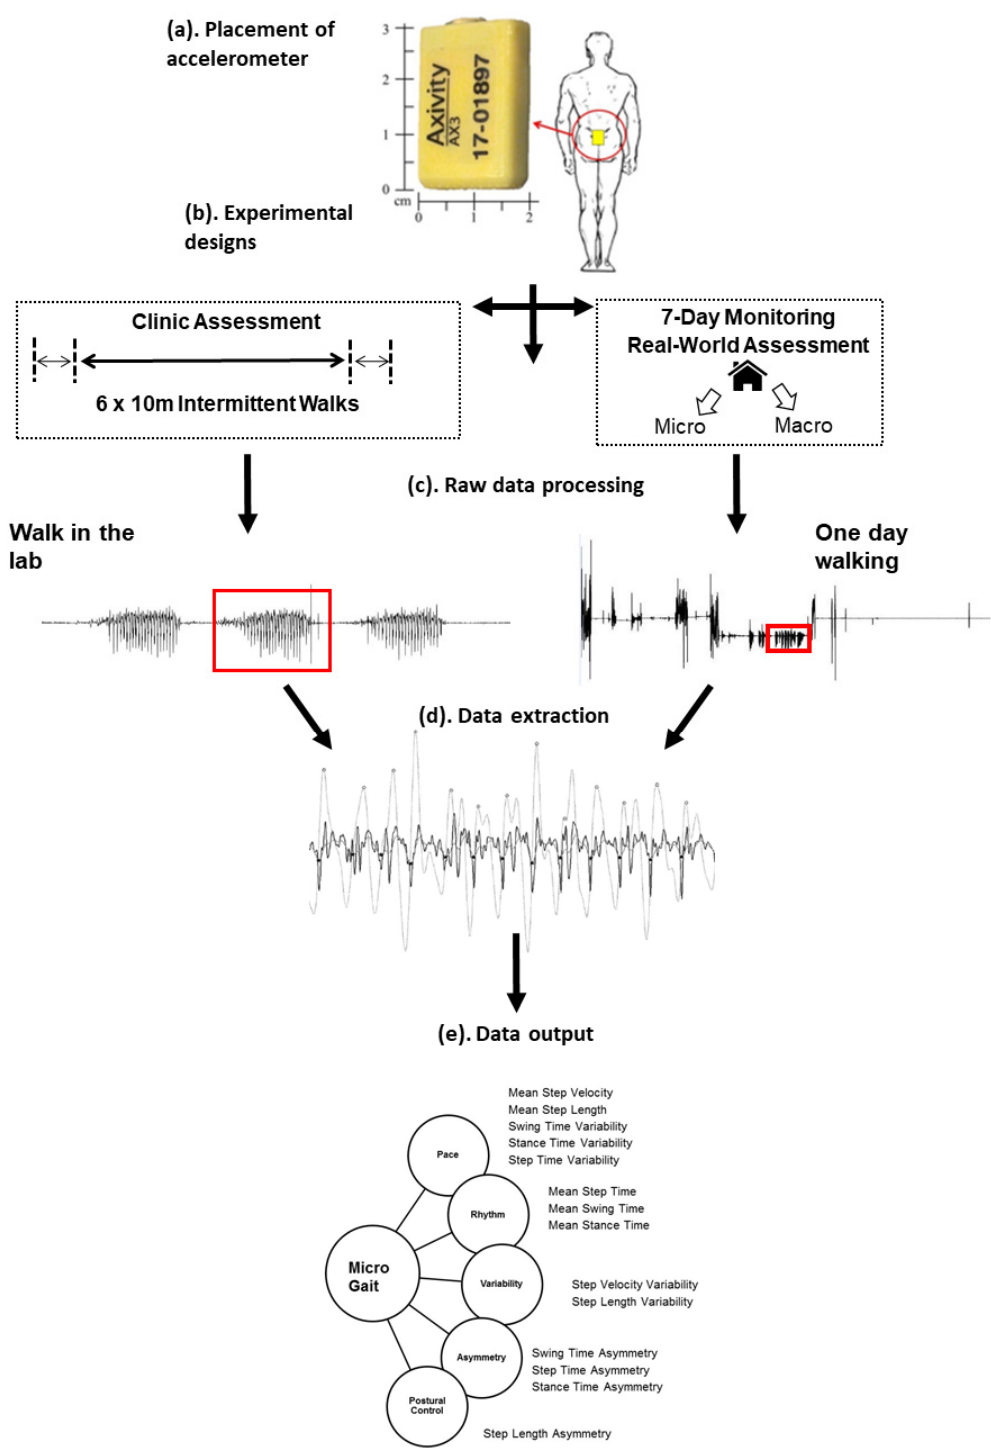
Figure 1. Illustration of gait protocol from initial body-worn monitor placement to data output, adapted from Mc Ardle [14]. ( a ) Example of body worn monitor placement for free-living data collection on L5 centrally located on the lower back; ( b ) gait protocols for lab and real-world assessment; ( c ) examples of lab and real-world accelerometer signals; ( d ) the raw vertical acceleration signal segmented into walking bouts; ( e ) conceptual model of gait representing domains and 14 gait characteristics. Figure adapted from Mc Ardle et al. (2018). The publication is available at IOS Press through DOI: